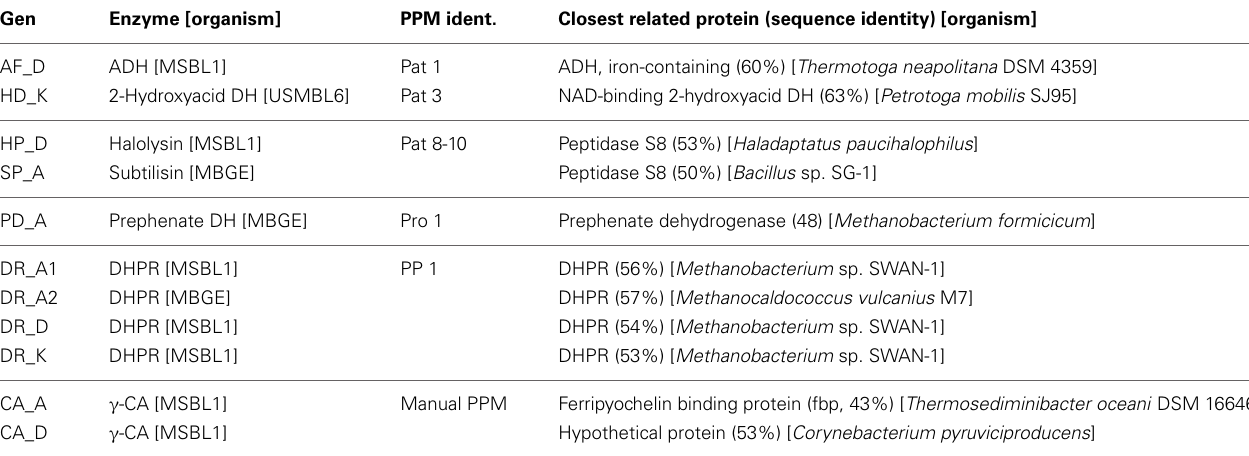
Table 7 | Hits identified as reliable using the PPM algorithm. Gen Enzyme